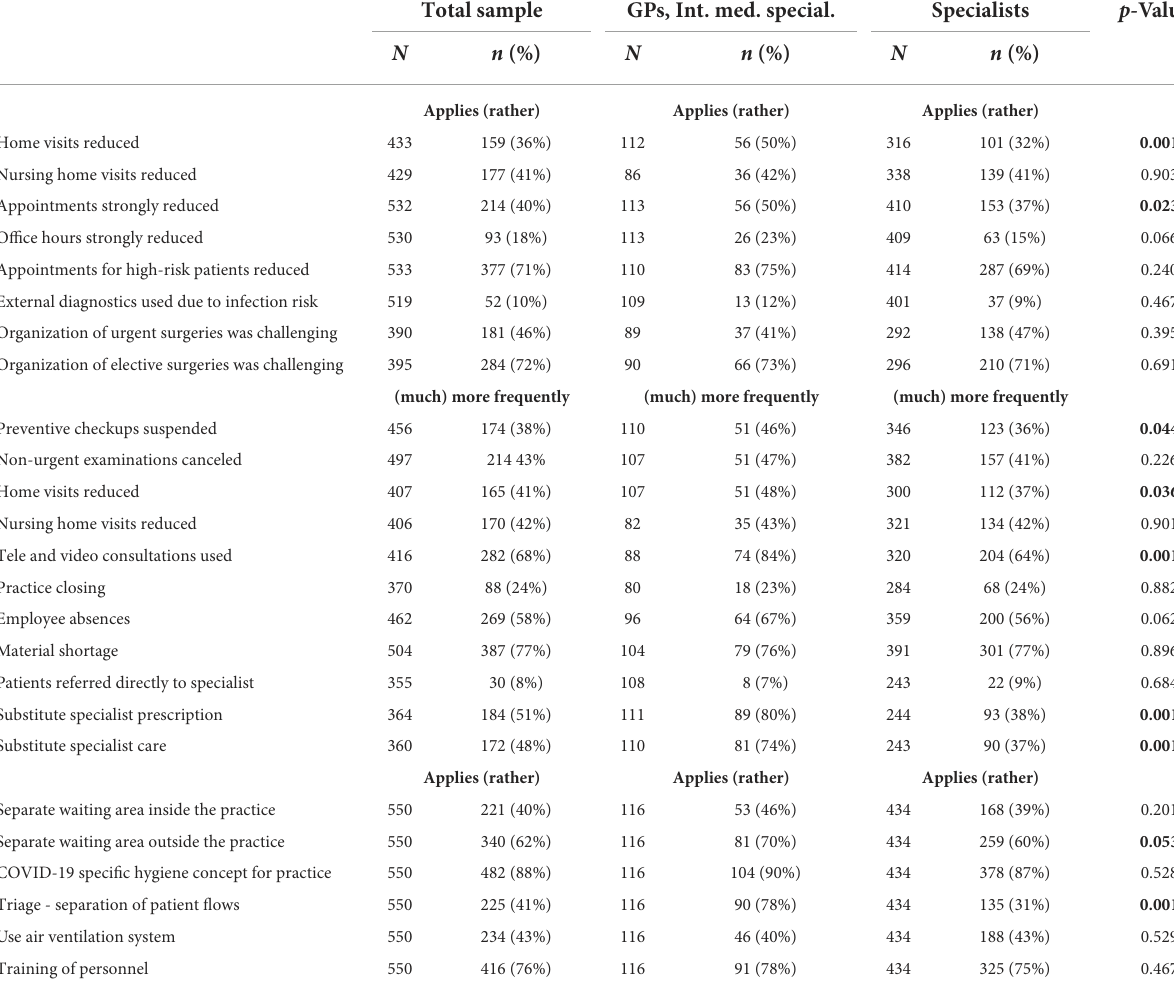
TABLE 5 Change in practice management in primary care and specialist